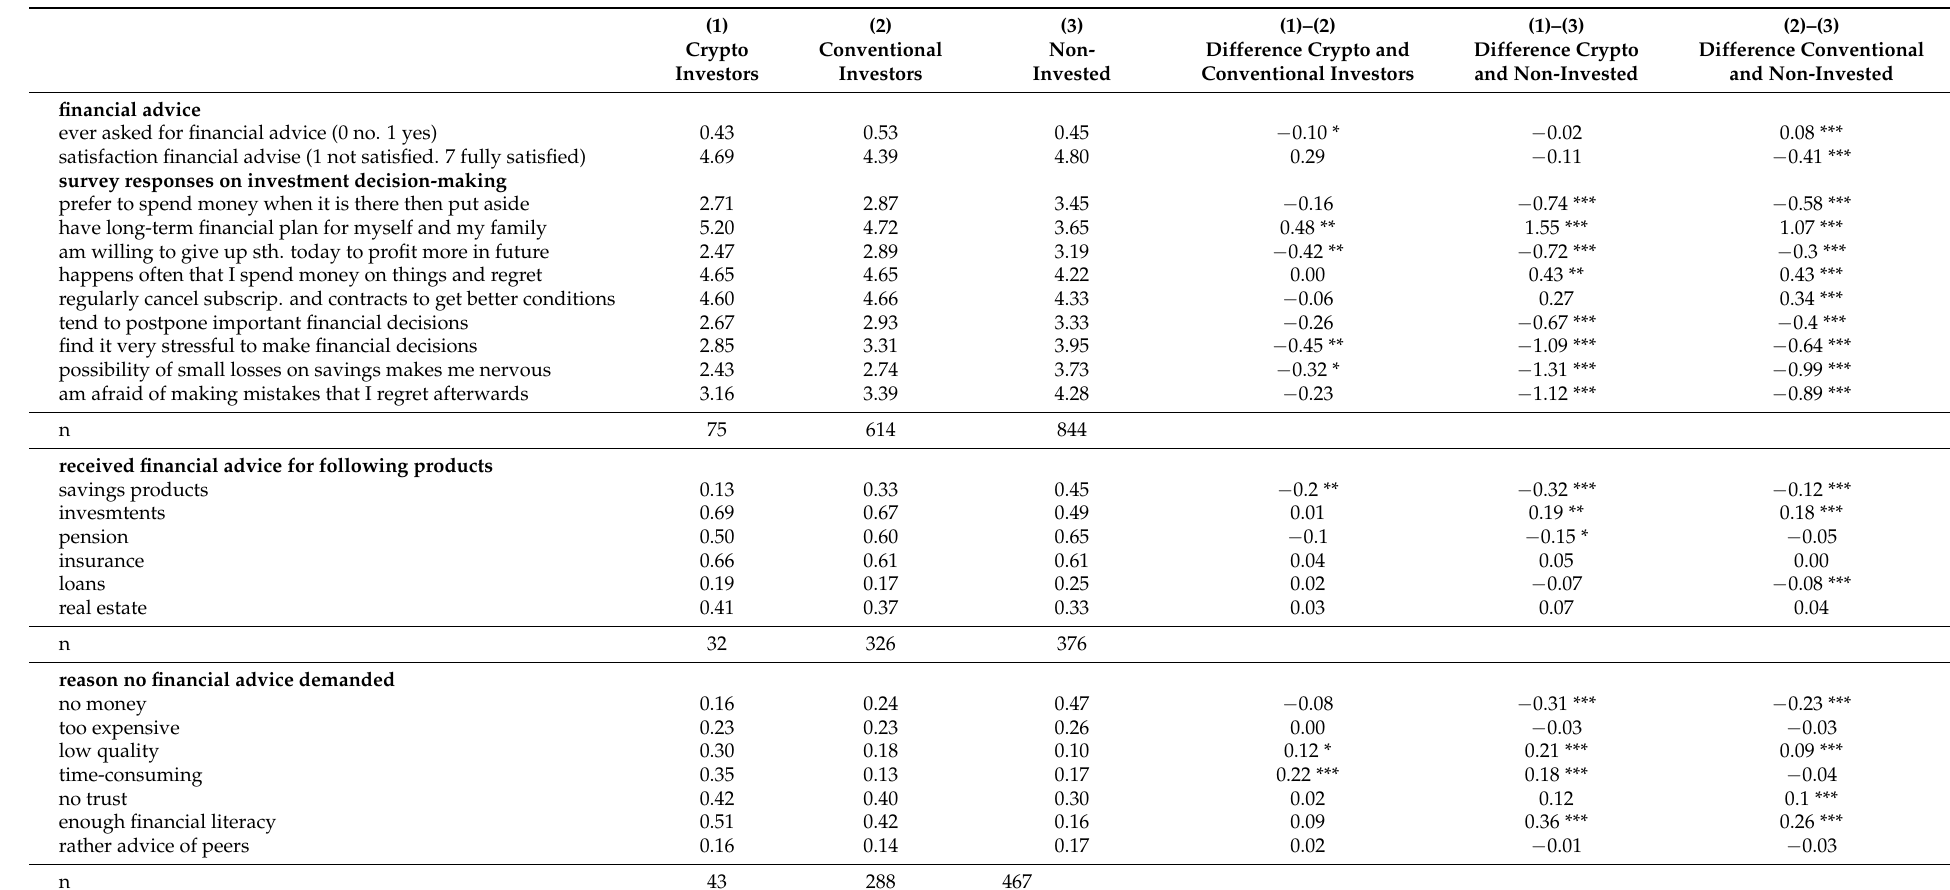
Table A7. Means and t -tests of crypto owners, conventional and non-investors of survey responses on financial decision-making and financial advice. Source: Own data.